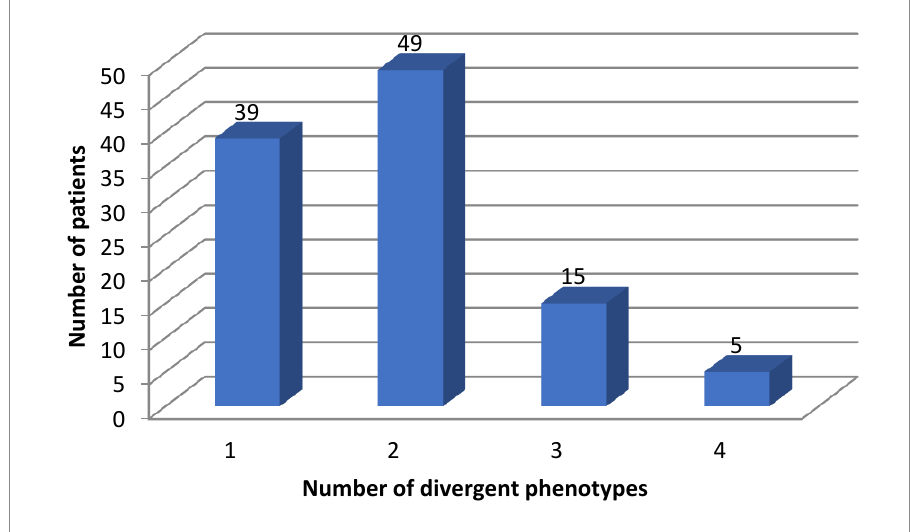
Figure 1. Number of divergent phenotypes for CYP enzymes in 108 patients.